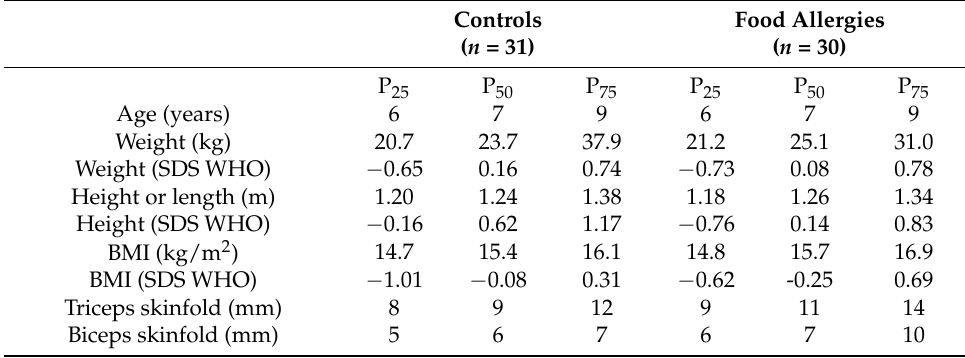
Table 2. Anthropometric measurements, resting energy expenditure (REE), and nutrient intake of the